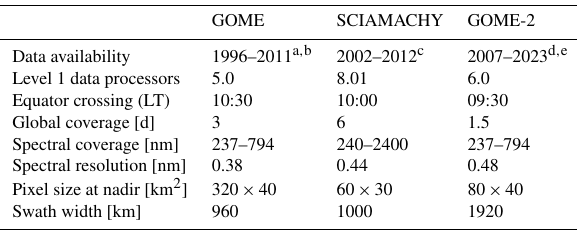
Table C1. Specifications of the instruments and data set versions selected for this